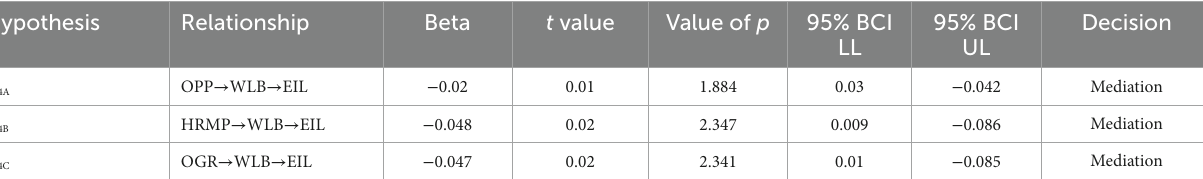
TABLE 5 Hypothesis testing indirect effect. Hypothesis